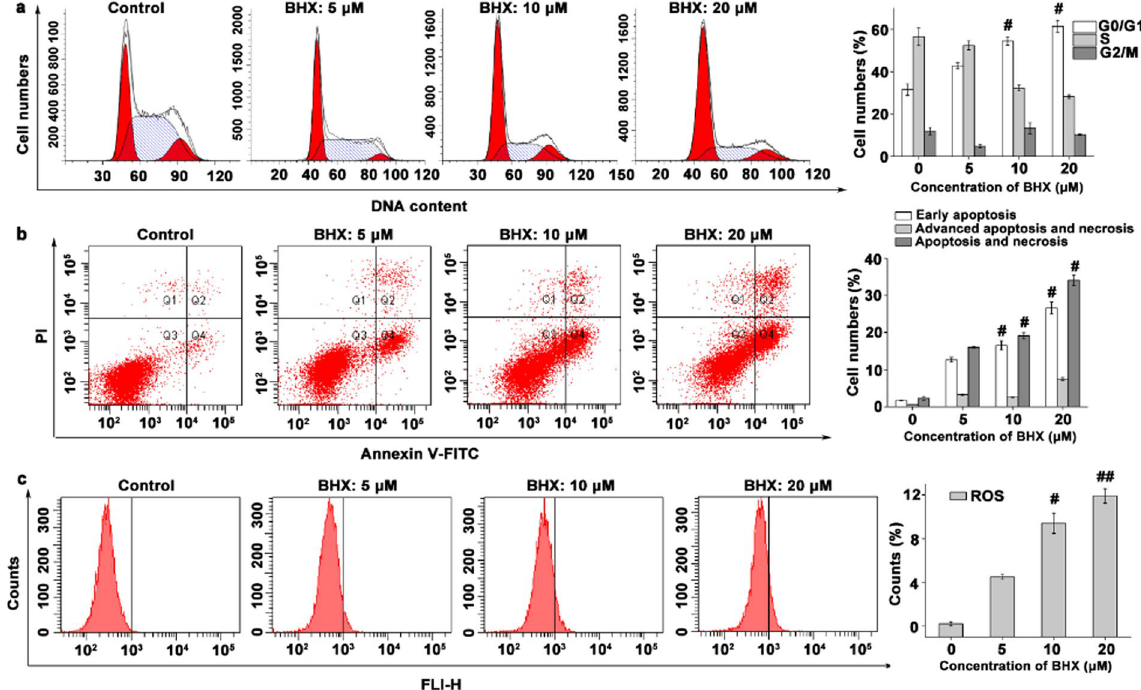
Figure 4. Effects of BHX on cell cycle progression, apoptosis, and intracellular ROS generation in MDA-MB-231 cells. BHX induced (a) G0/G1 arrest, (b) early apoptosis, and ( c) intracellular ROS generation in MDA-MB-231 cells. Data are expressed as means ± S.D. from three independent experiments. # p < 0.05 and ## p < 0.01.